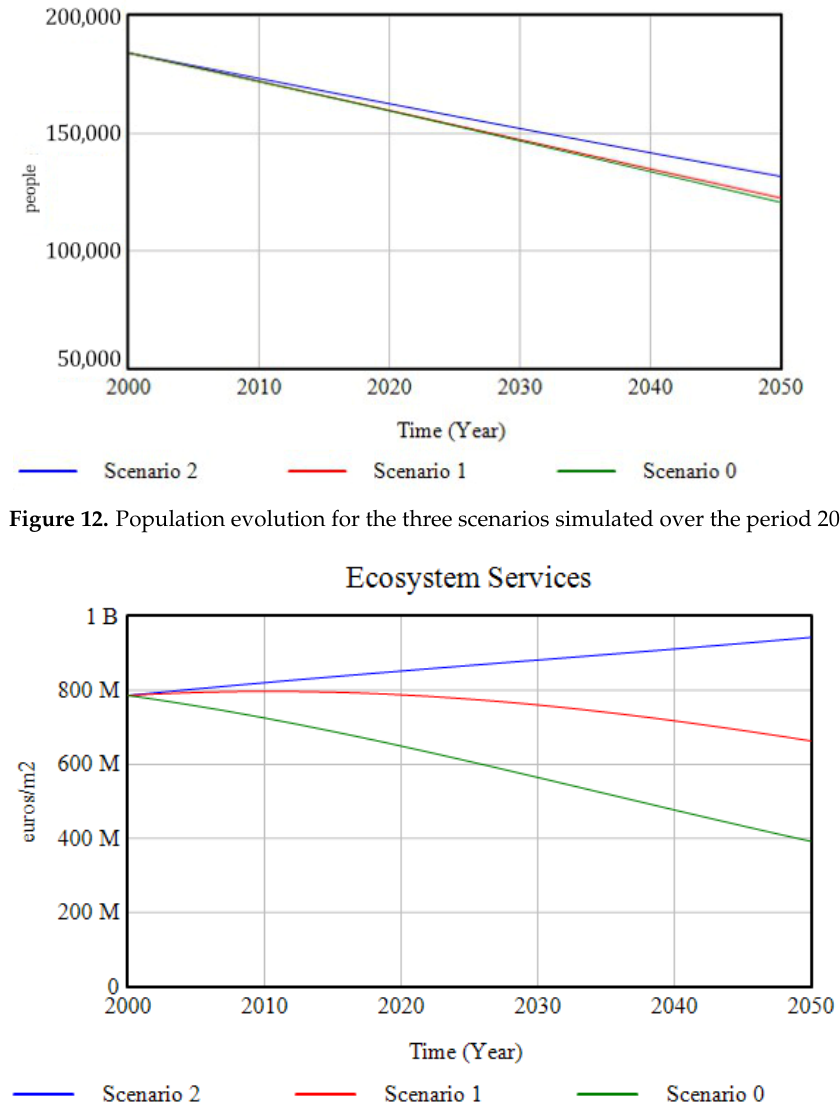
Figure 13. Ecosystem services evolution for the three simulated scenarios over the period 2000–2050.